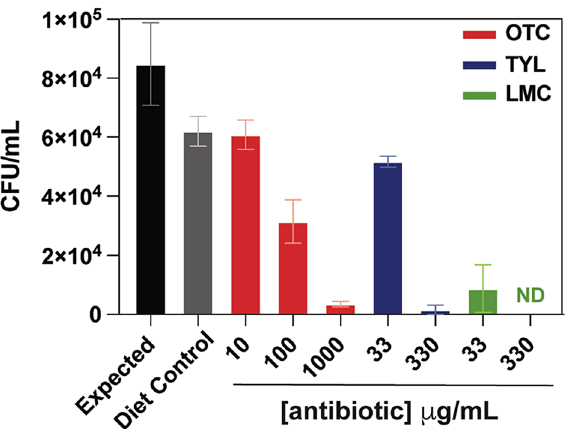
Figure 2. Survival of M. plutonius in larval diet and diets supplemented with antibiotics. Recovery of M. plutonius 2019BC1 from diets is presented in CFU/mL after a 30 min incubation in control larval diet A (grey) or larval diet A containing various concentrations of OTC (red), TYL (blue), or LMC (green). Expected (black) represents expected recovery of M. plutonius in KSBHI with no antibiotic or diet component. The mean and standard deviations are plotted. The detection limit was 20 CFU/mL. ND indicated no